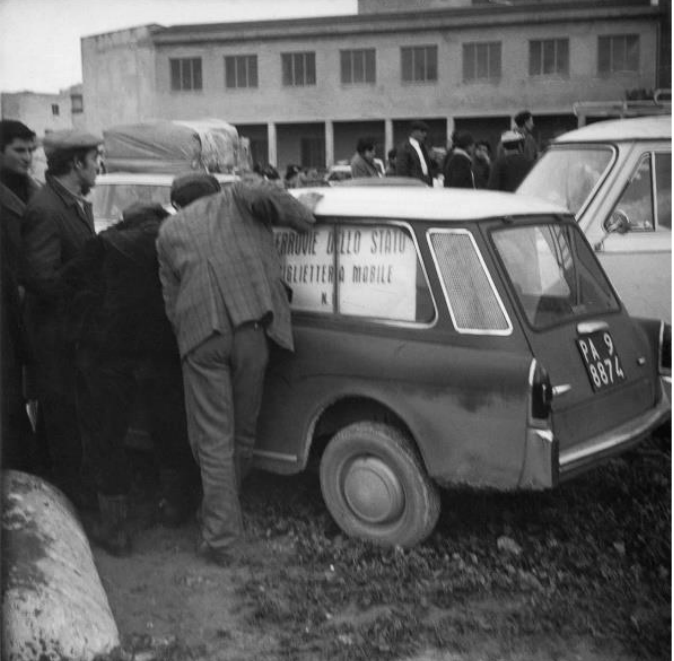
Figure 7. “Flying” ticket offices of the FF. SS. (Italian railway company), 22 January 1969; free train tickets were available for the entire population of the Belìce Valley for every destination. Photo: Archivio de L’Ora, Biblioteca Regionale Siciliana “Alberto Bombace”, Palermo.